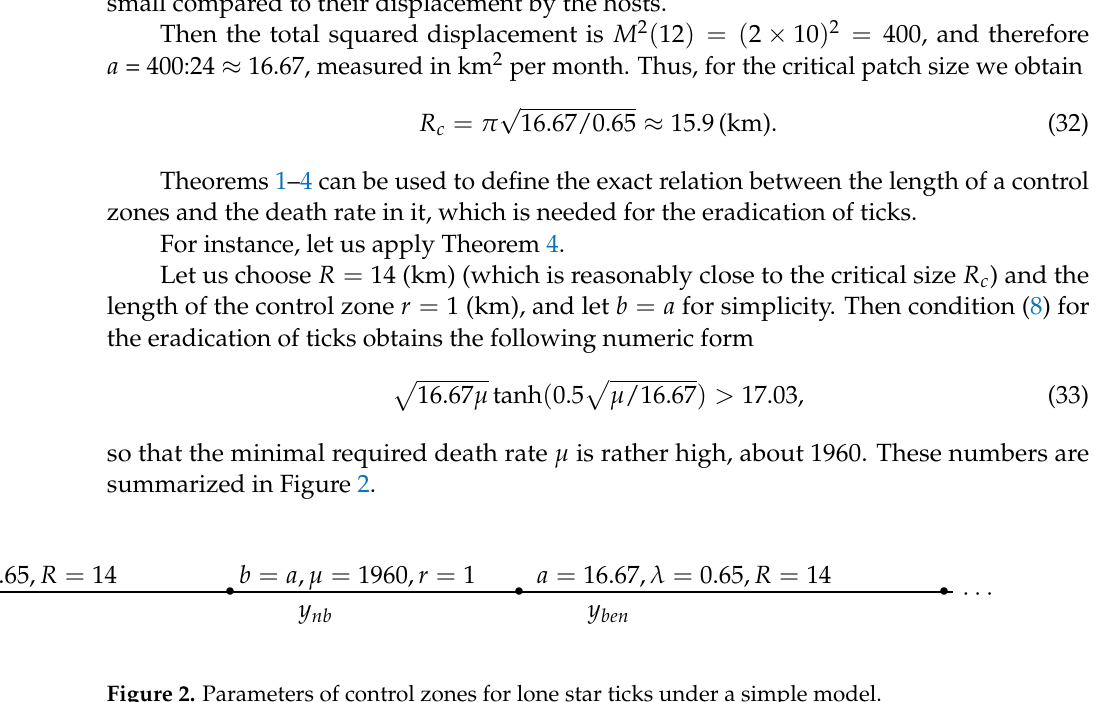
Figure 2. Parameters of control zones for lone star ticks under a simple